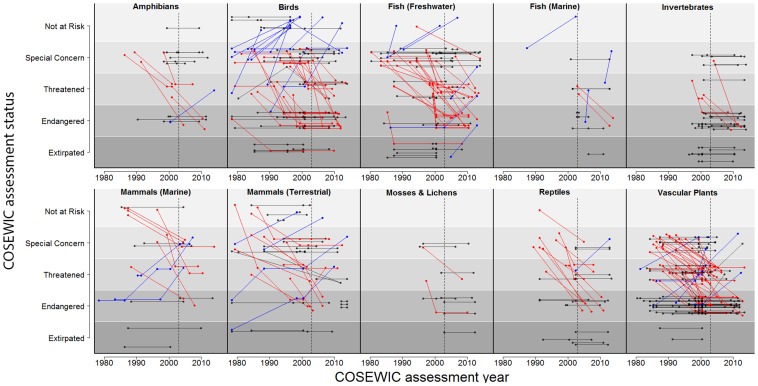
Overview of COSEWIC assessment statuses for all species that have been assessed more than once, and that have never been data deficient or taxonomically reassigned.Each species is represented by points (assessment date and outcome) connected by lines. Species that deteriorated in status from their first to final COSEWIC assessments are red, species that have improved are blue, and species that have remained constant are black. The vertical dotted line indicates 2003, or the passing of SARA. Species whose apparent recovery was due to increased sampling effort, and not biological recovery (N = 20) are not shown.